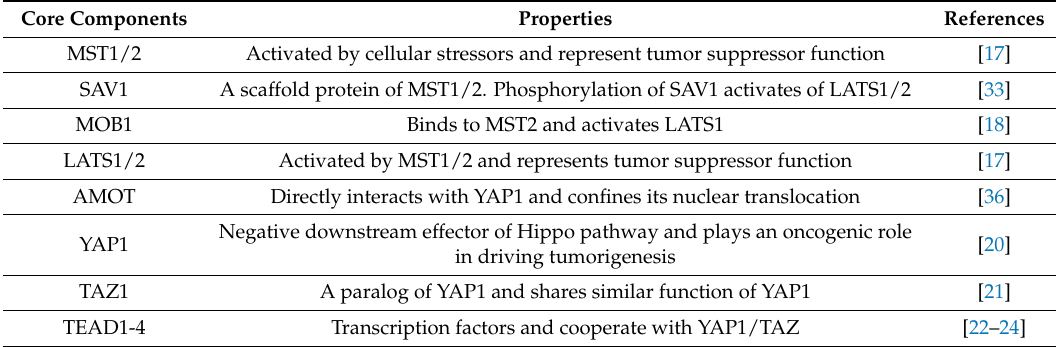
Table 1. Main components and properties of Hippo